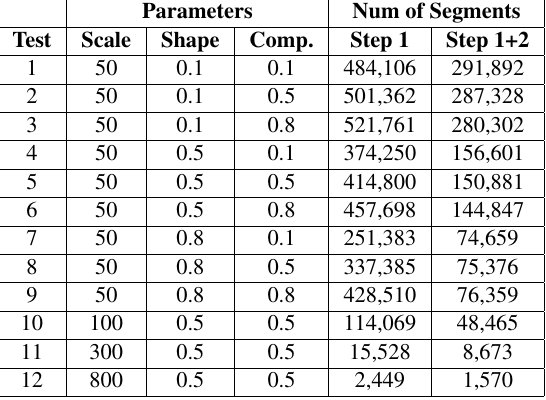
Table 1. Summary of Tests Performed